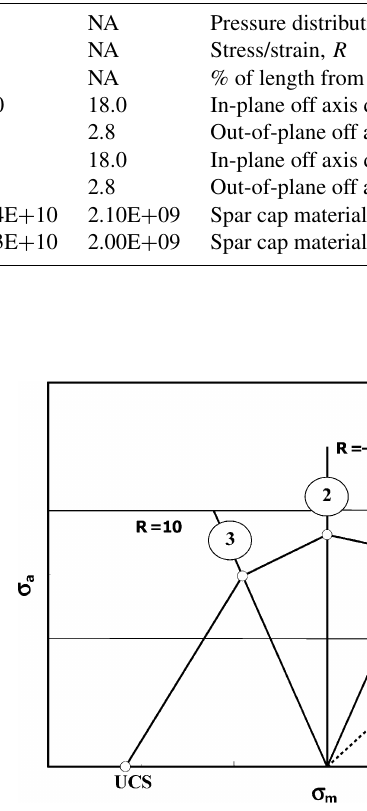
Figure 6. Representative GFRP constant life diagram (Mandell et al., 2010). Figure 7. Approximate constant life diagram represented as a piecewise linear